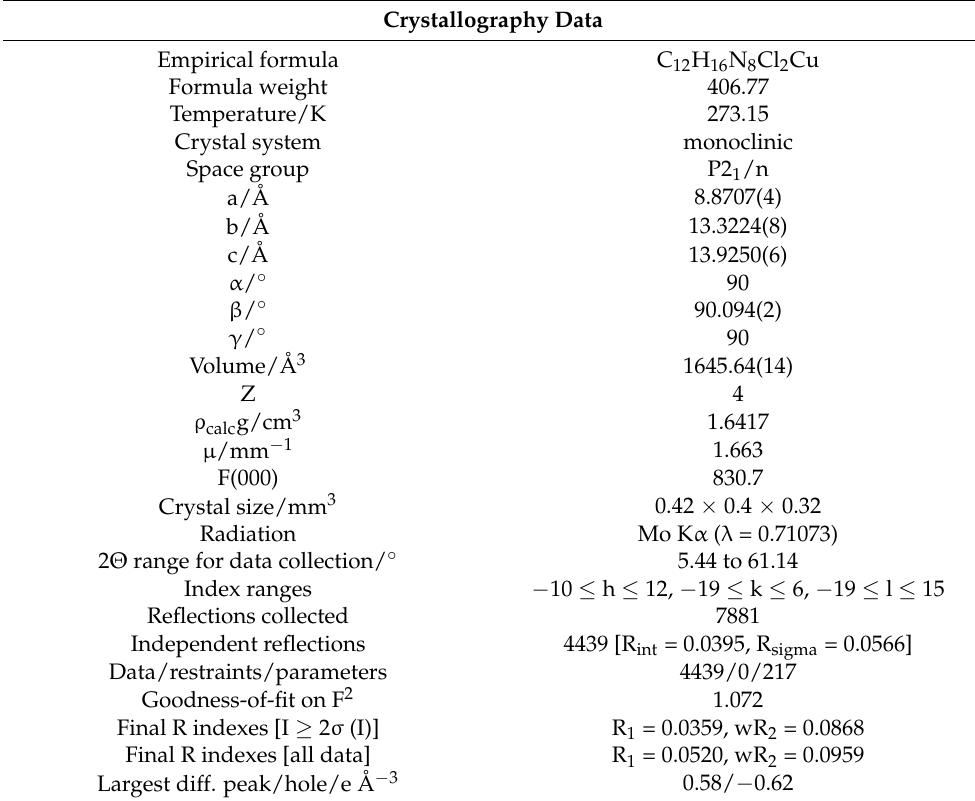
Table 1. Crystallography data for Chloridotetrakis(imidazole)copper(II) chloride, [Cu(II)(C 3 N 2 H 4 ) 4 Cl]Cl.